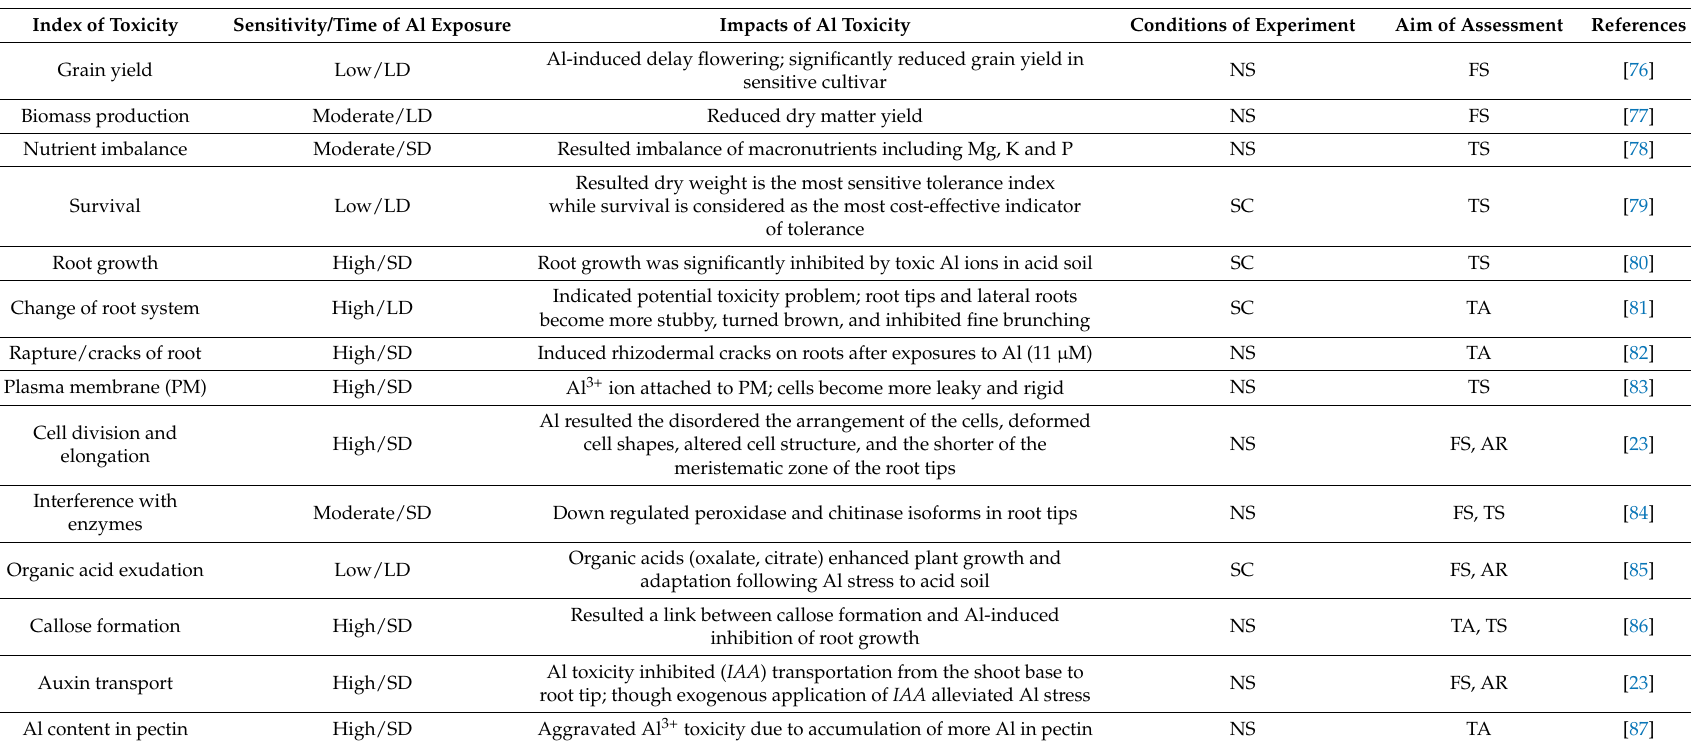
Table 2. Impacts of aluminum toxicity in